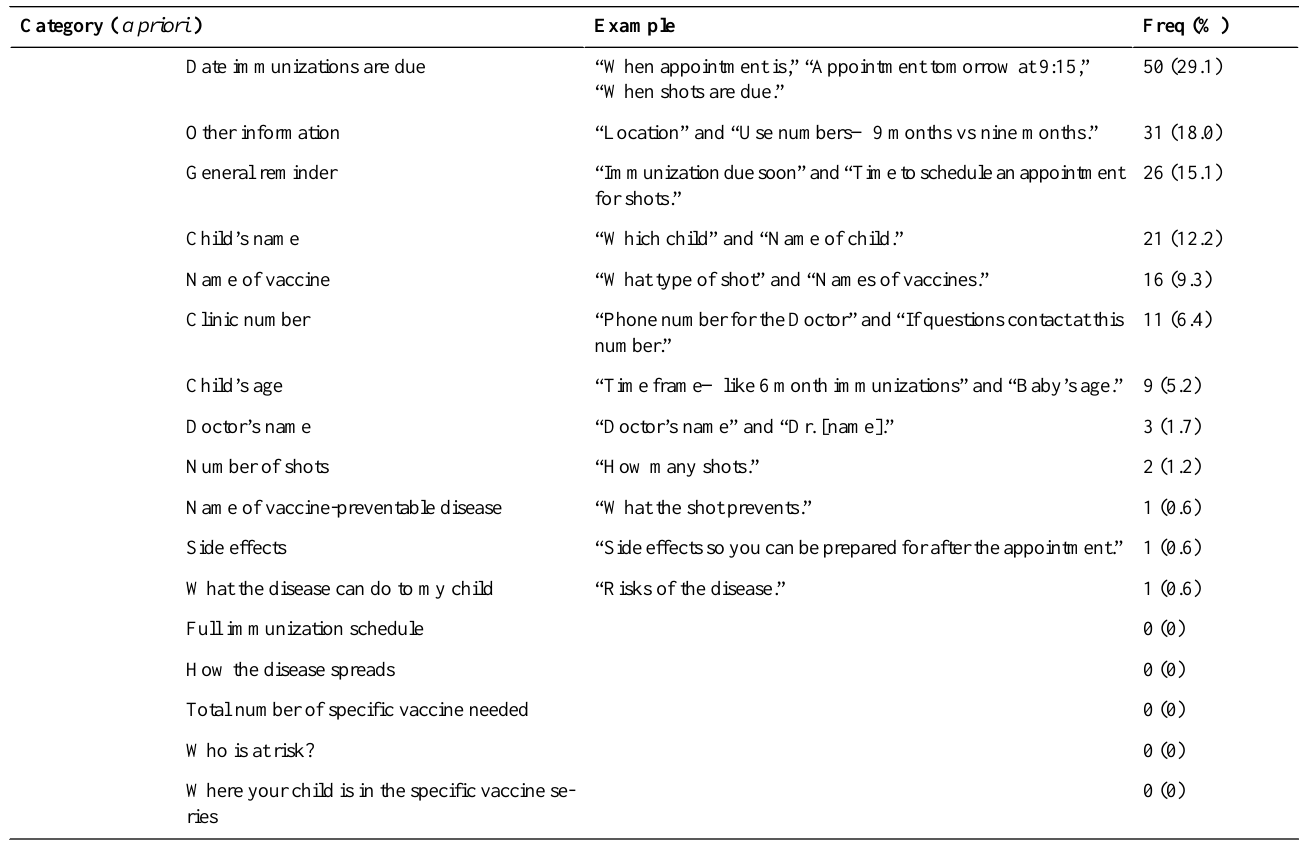
Table 2. Frequency of participant comments (N = 172) about preferred text message immunization reminder information.